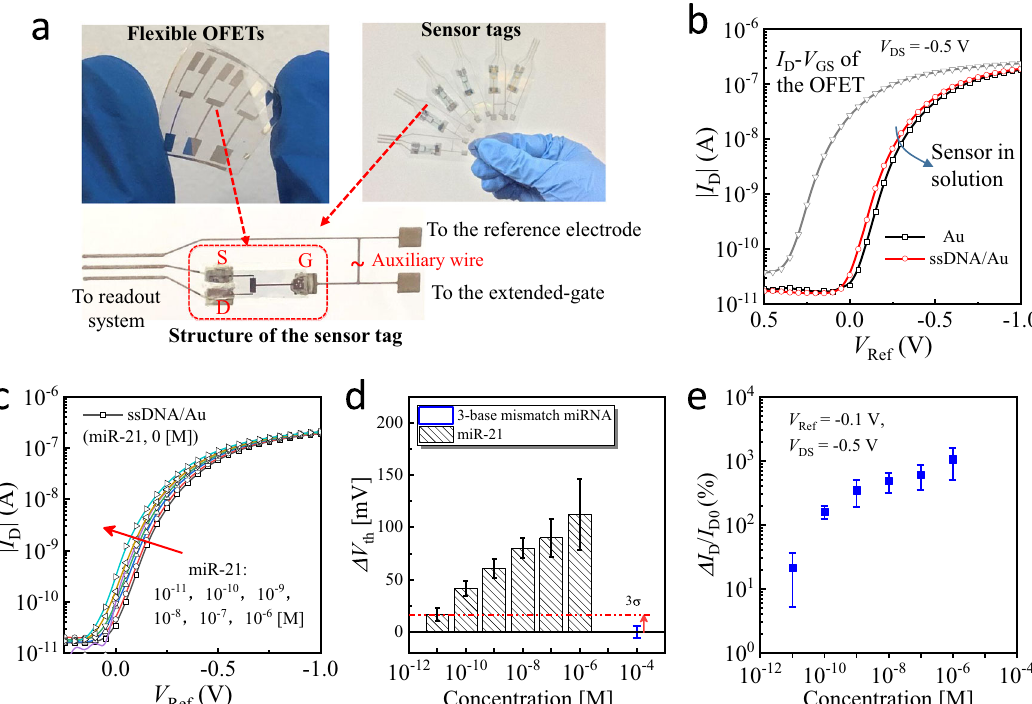
Fig. 5 Performance of low-voltage OFET miRNA sensor. a Photo images of the fabricated OFETs on PEN substrate, and the sensor tags consisting of an encapsulated OFET and contacts for extended-gate sensing electrode and reference electrode. b Measured I D – V Ref curve by sweeping V Ref after the sensor being placed in the electrolyte solution, presenting an obvious shift to the negative direction compared with the I D – V GS curve of the pristine OFET. After immobilization of ssDNA probes onto the sensing electrode, there is a small shift backward due to the negatively charged probes. c Measured I D – V Ref curves for the concentration of miR-21 targets varying from 0 to 1 μ M. d Extracted V th shift ( Δ V th ) of the curves at various concentrations of miR-21 with the test results for the 3-base mismatch miRNA as the background level. The dashed lines indicate the limit of detection (LOD) obtained from three-times the standard-measurement error bar of the blank noise. Error bars indicate standard deviations. e The measured relative current change from the background level ( Δ I D / I D0 ) at V Ref = − 0.1 V for various miR-21 concentrations. Error bars indicate standard deviations.